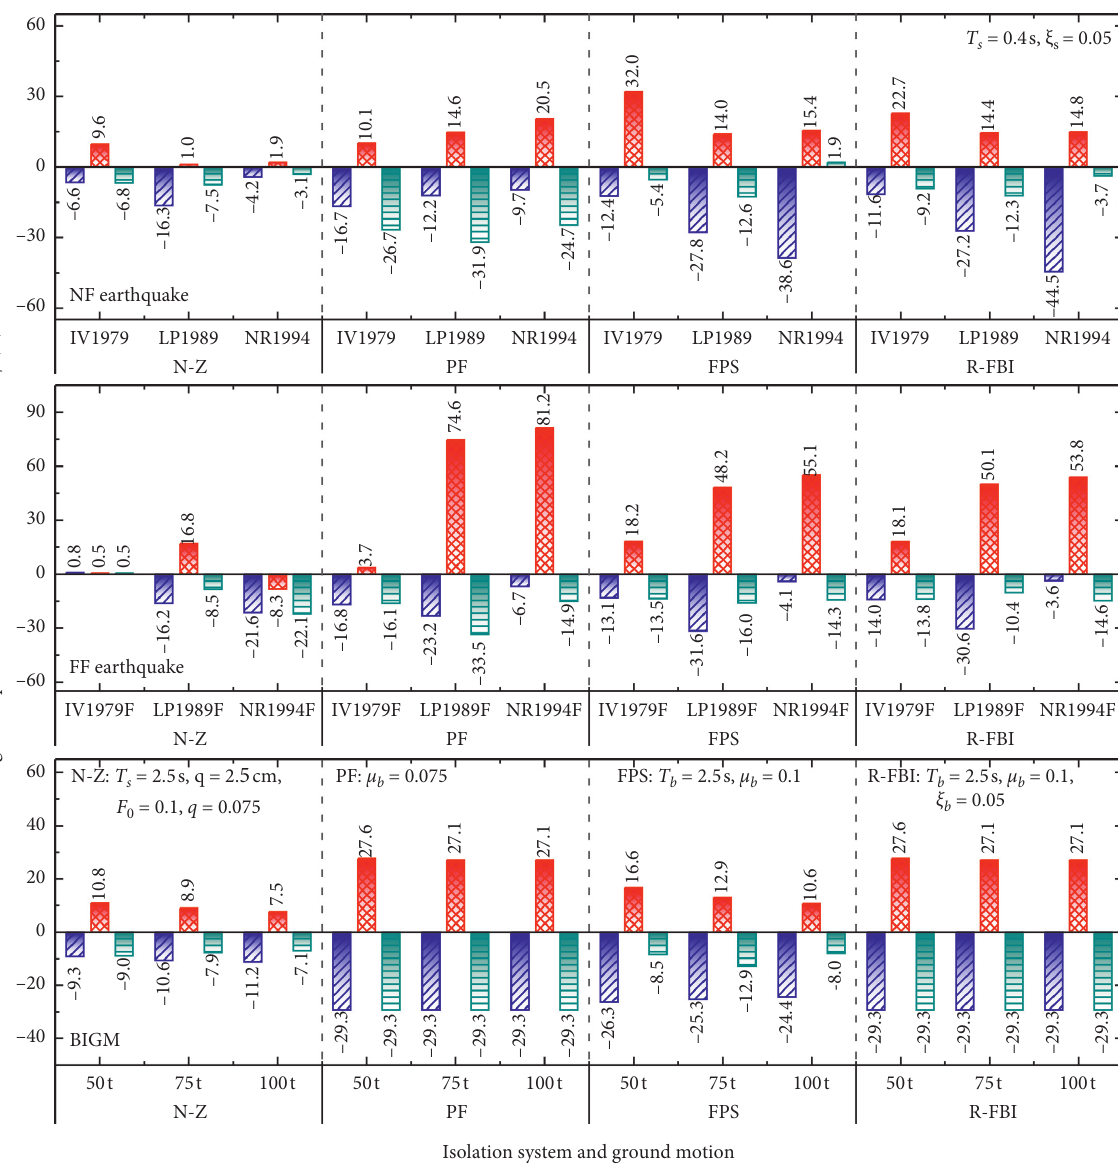
Figure 7: The effect of bidirectional interaction on the top floor acceleration, isolator displacement, and base shear response under earthquake and blast-induced ground